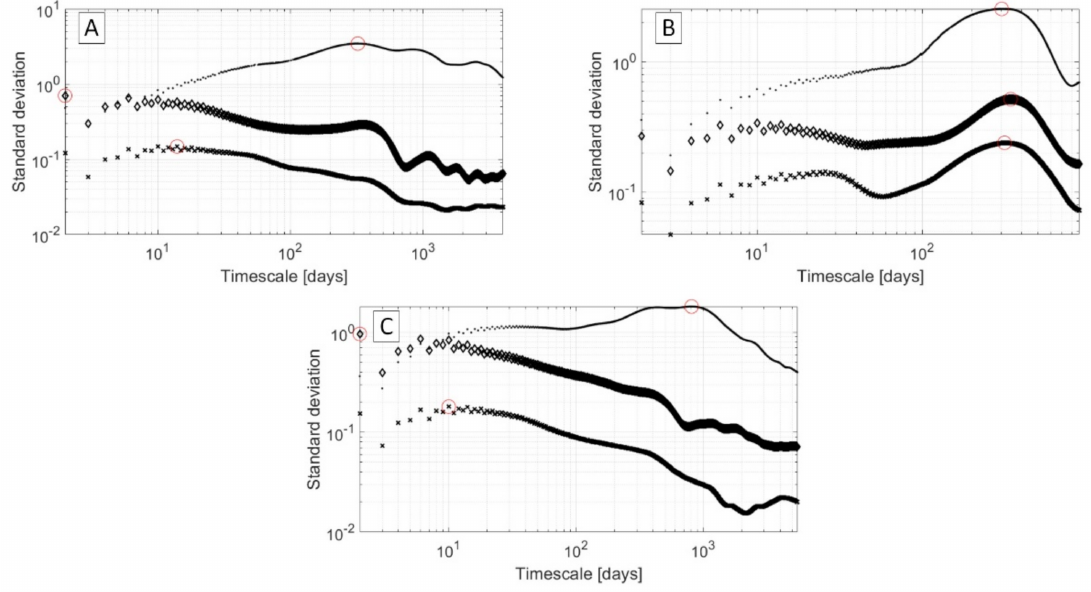
Figure 1. Temporal spectra of the shoreline position (dotted), wave height (crosses) and wave period (diamonds), for the dataset at Narrabeen ( A ), Nha Trang ( B ) and Tairua ( C ). The red circle indicates the most dominant